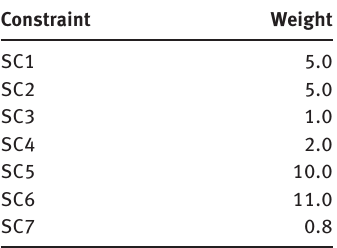
Table 1: Weights of Violating the Soft